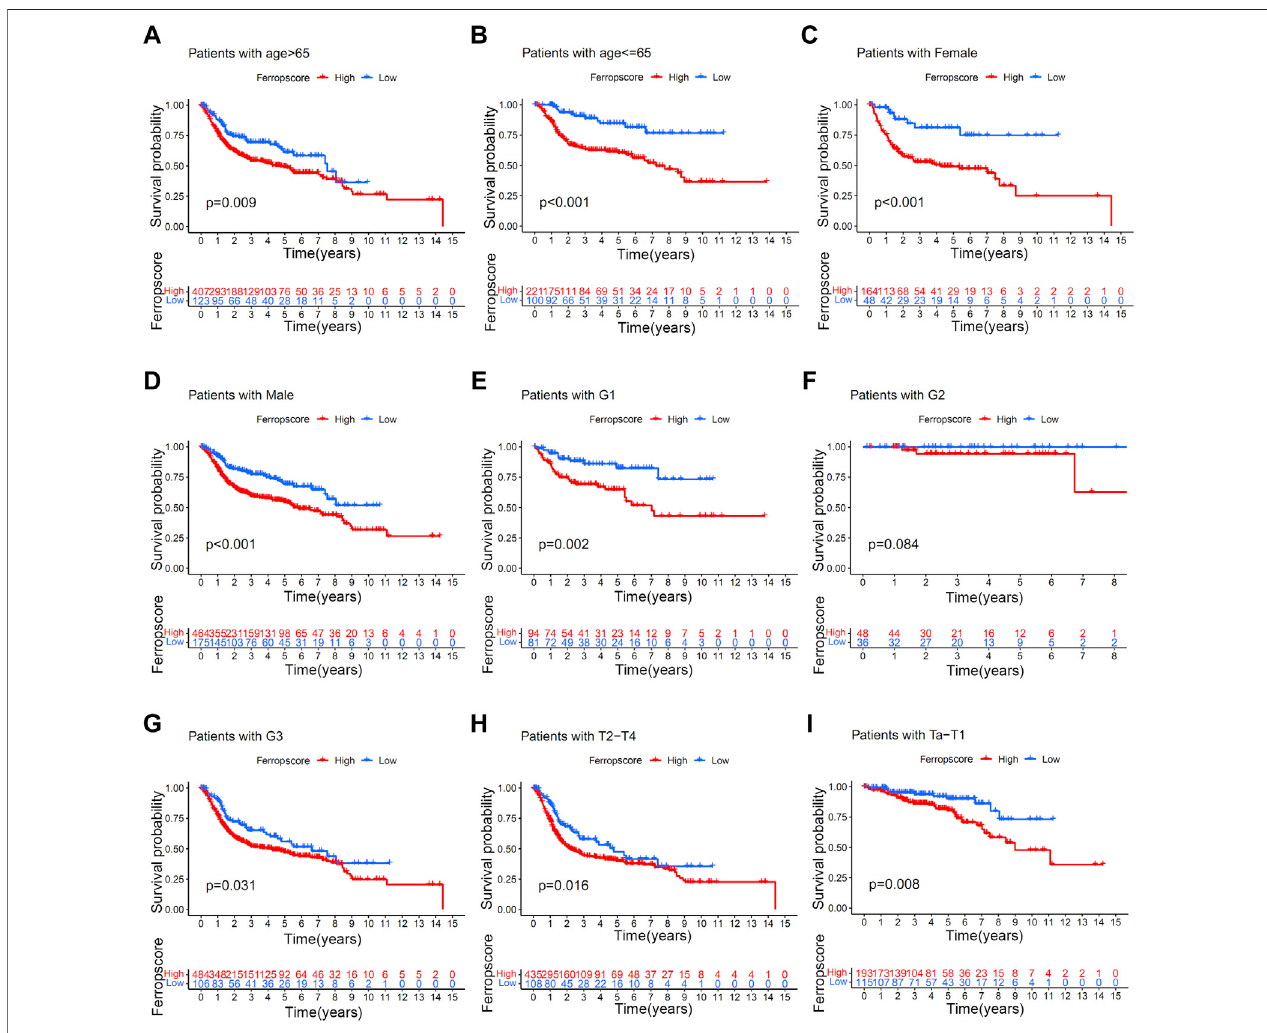
FIGURE8| Kaplan – Meiersurvivalanalysisofhigh/lowferropscoresindifferentsubgroupsofthemergedcohort. (A) Kaplan – Meiersurvivalanalysisinpatientsaged > 65 years. (B) Kaplan – Meier survival analysis in patients aged ≤ 65 years. (C) Kaplan – Meier survival analysis in female patients. (D) Kaplan – Meier survival analysis in malepatients. (E – G) Kaplan – Meiersurvivalanalysisinpatientswithgrade1,grade2andgrade3disease. (H) Kaplan – MeiersurvivalanalysisinpatientswithTa – T1stage disease. (I) Kaplan – Meier survival analysis in patients with T2 – T4 stage disease.